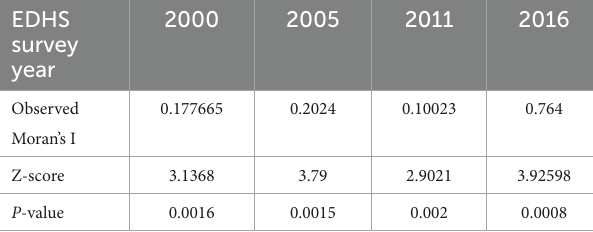
TABLE 2 Summary results of global Moran’s